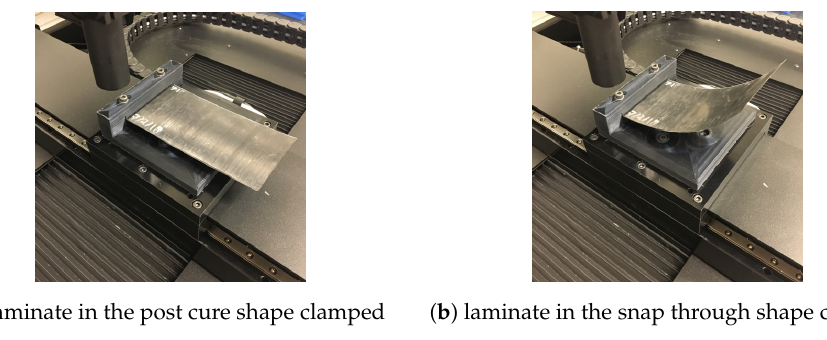
Figure 7. The post cure and snap through shapes.